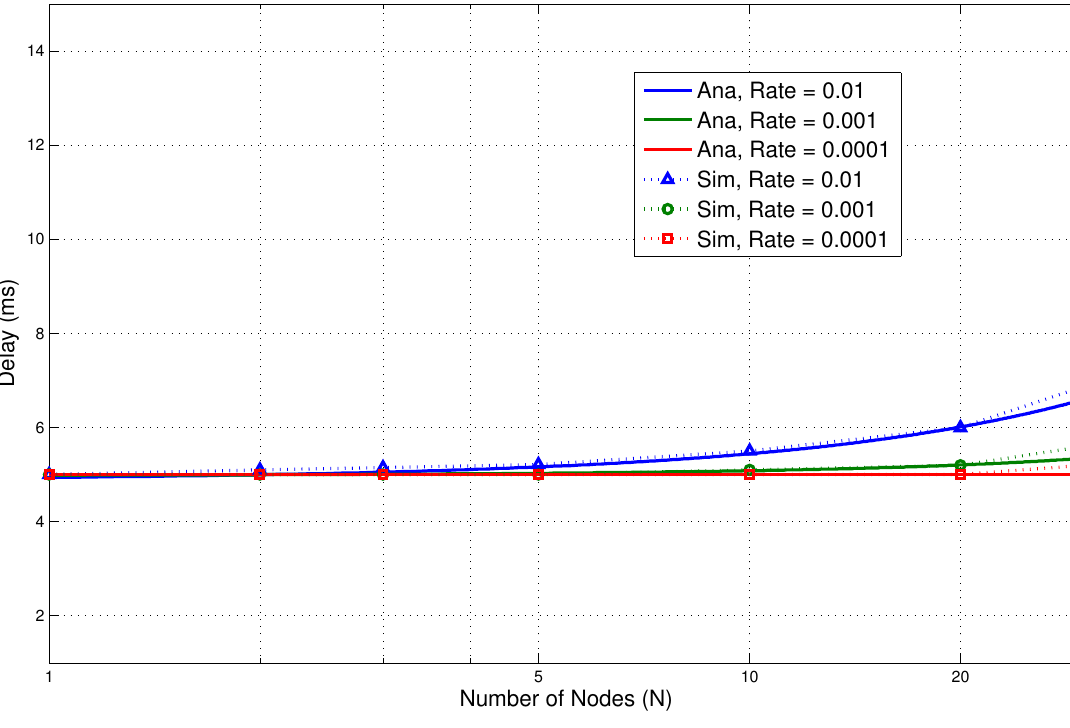
Figure 18. Emergency traffic